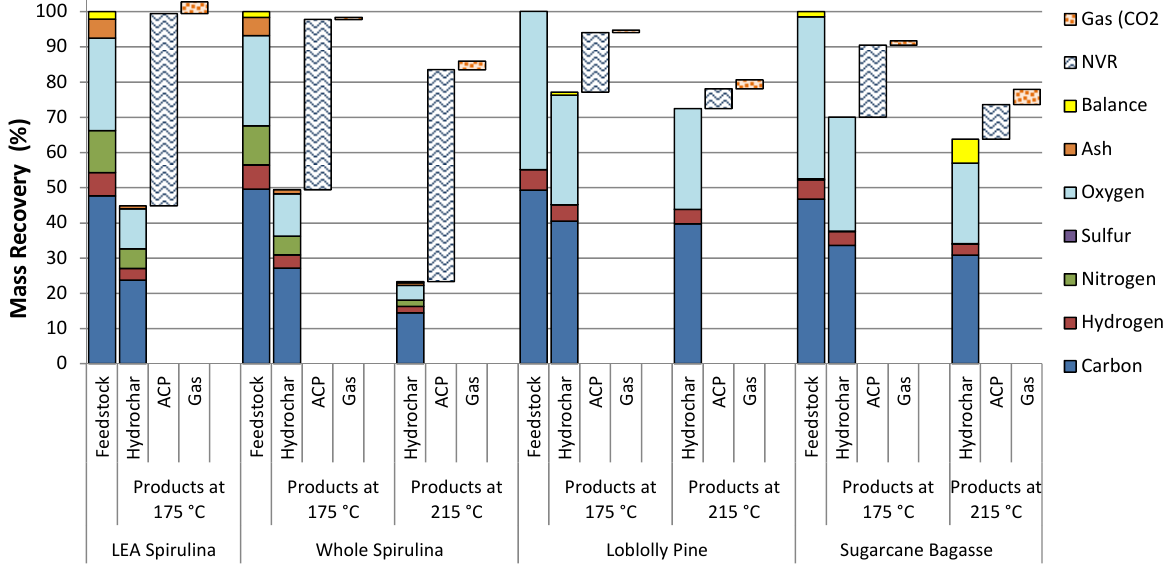
Figure 1. Mass recoveries from HTC treatment of LEA and whole Sprirulina in comparison with loblolly pine and sugarcane bagasse (from [23]). The “balance” of the solids is equal to 100% ‒ C ‒ H ‒ N ‒ S ‒ O ‒